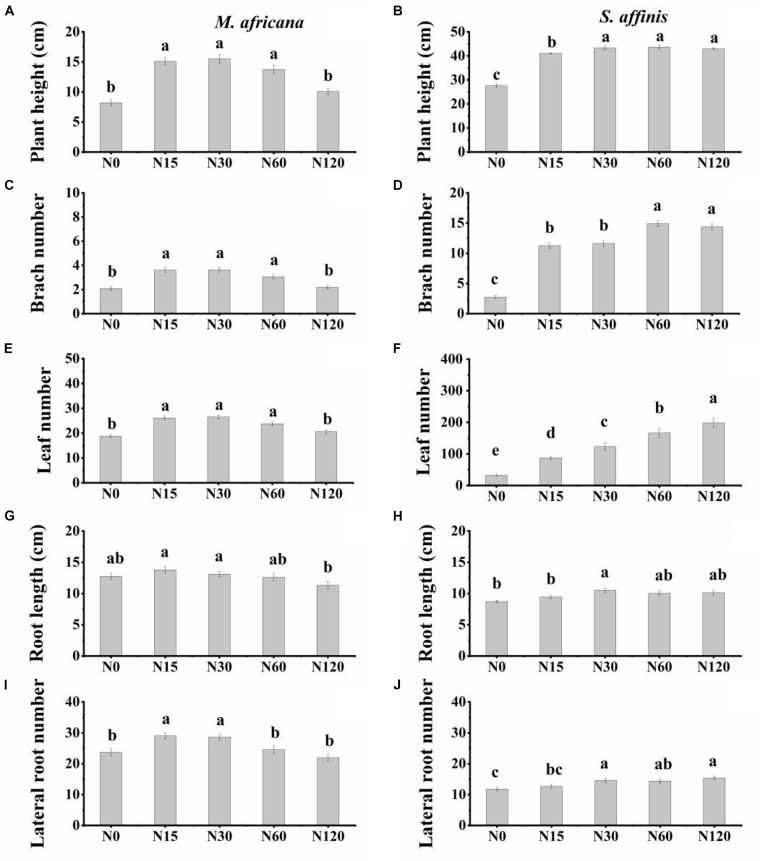
Plant height, number of branches, number of leaves, root length, and number of lateral roots of M. africana
(A,C,E,G,I) and S. affinis
(B,D,F,H,J) for each treatment. Bars represent means ± standard error (n = 10). Columns with different lowercase letters differ significantly at P = 0.05.